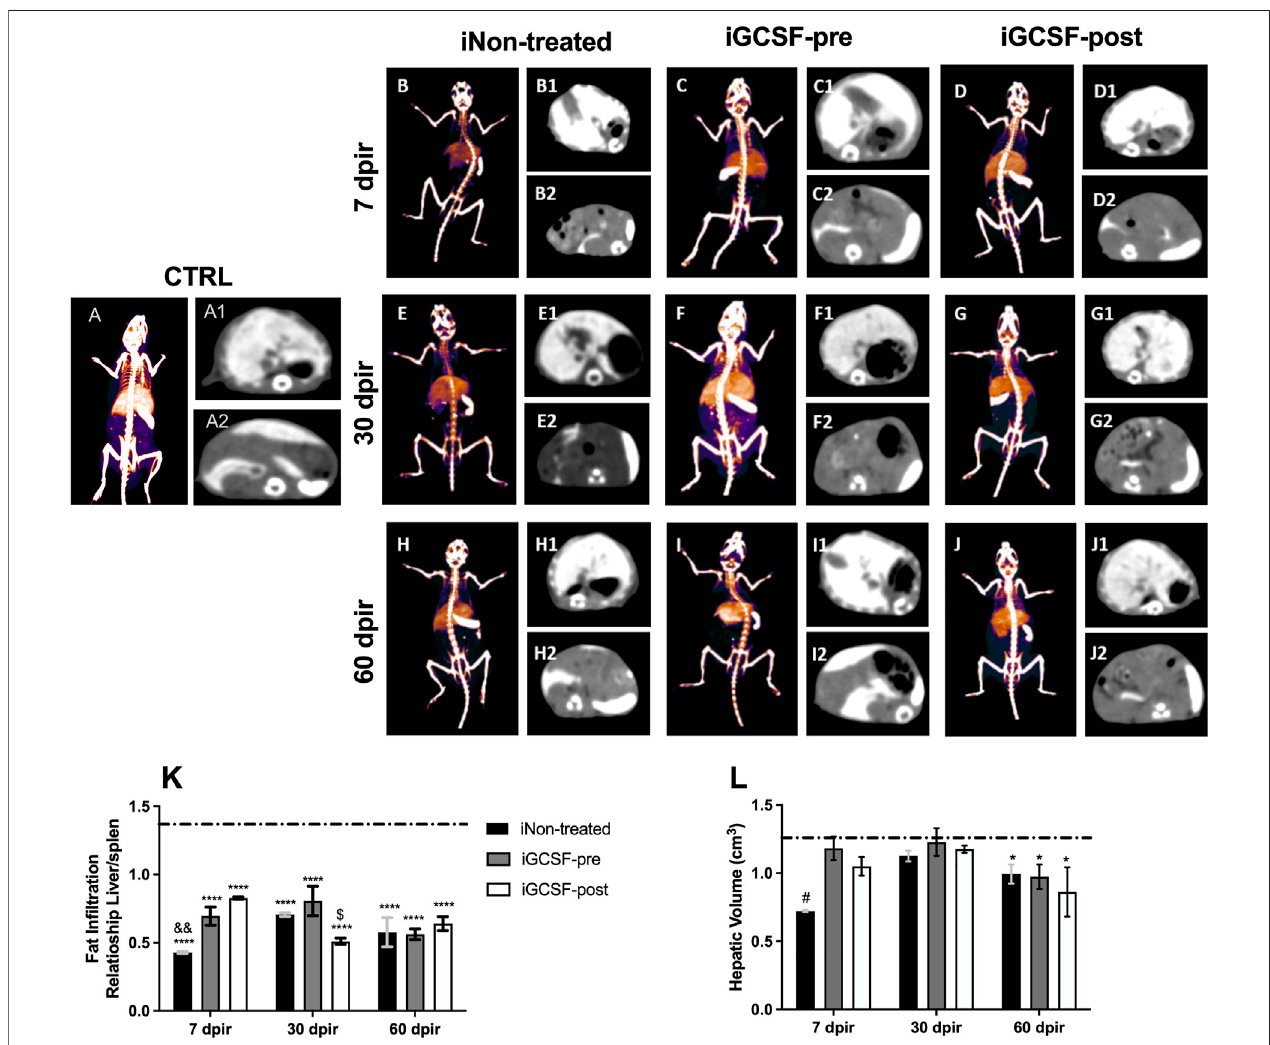
FIGURE 5 | Assessment of liver volume and fat in fi ltration by computed tomography. Computed tomography 48 h after intravenous administration of EXITRON NANO 12000 contrast. CTRL-3D volumetric reconstruction (A) , axial slice showing contrast enhancement by the Liver (A1) and Spleen (A2) at a control animal. iNon- treated-3D volumetric reconstruction 7 (B) , 30 (E) , and 60 (H) dpir, axial slice showing contrast enhancement by the Liver and Spleen 7, 30 and 60 dpir (B1,B2, E1,E2, H1,H2) .iGCSF-pre — 3Dvolumetricreconstruction7 (C) ,30 (F) and60 (I) dpir,axialsliceshowingcontrastenhancementbytheLiverandSpleen7,30and60dpir (C1,C2, F1,F2, I1,I2) . iGCSF-post — 3D volumetric reconstruction 7 (D) , 30 (G) and 60 (J) dpir, axial slice showing contrast enhancement by the Liver and Spleen 7, 30 and 60 dpir (D1,D2, G1,G2, J1,J2) . (K) Liver/Spleen ratio among the three groups showing that at 7 dpir iNon-treated group was classi fi ed as having severe in fi